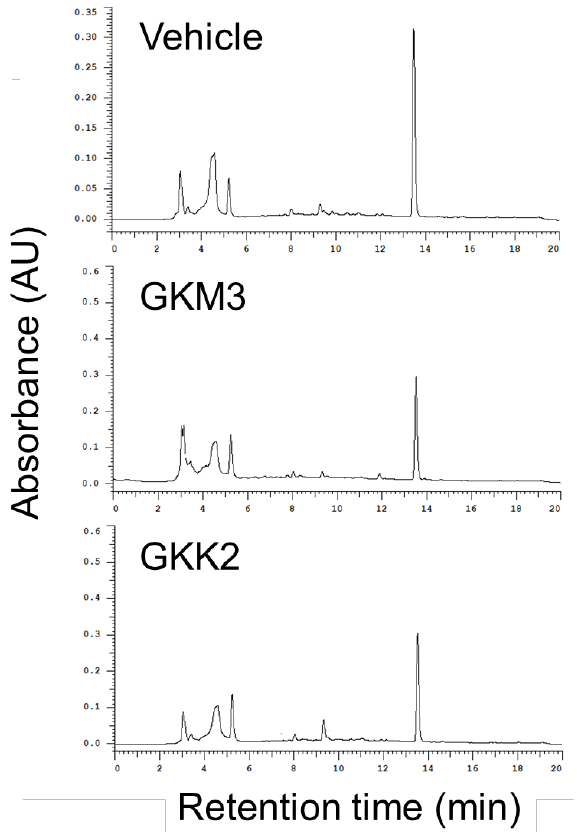
Figure 7. Methylglyoxal-trapping ability of GKM3 and GKK2. Data were expressed as the % of trapped methylglyoxal per 20 µ L of samples. Data shown are means of results obtained from two independent